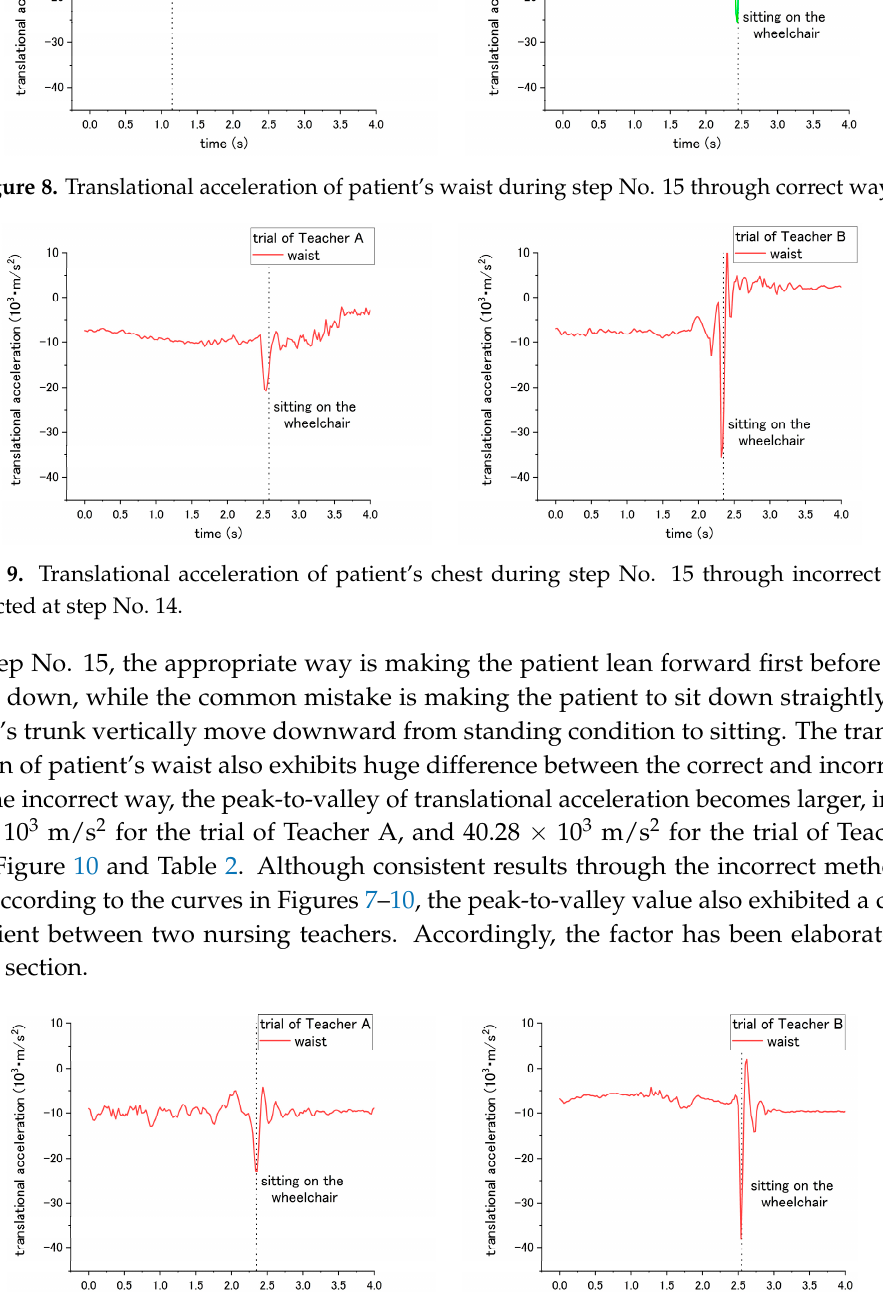
Figure 10. Translational acceleration of patient’s waist during step No. 15 when incorrect way was conducted at step No.